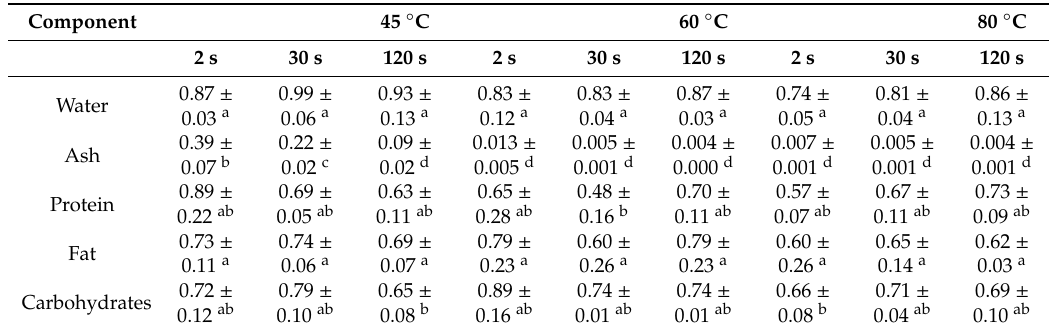
Table 3. True retention factors post processing relative to the fresh sugar kelp. The retention factors are presented in means ± SD ( n = 3).